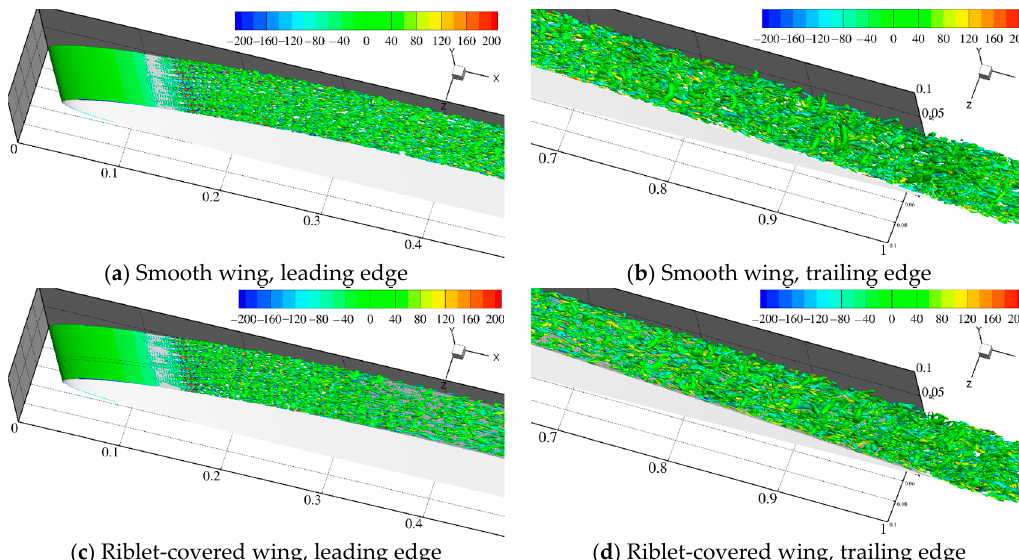
Figure 19. Instantaneous iso-surface of Q-criterion Q ( C / U ∞ ) 2 = 750 (colored by the nondimensional streamwise vorticity).